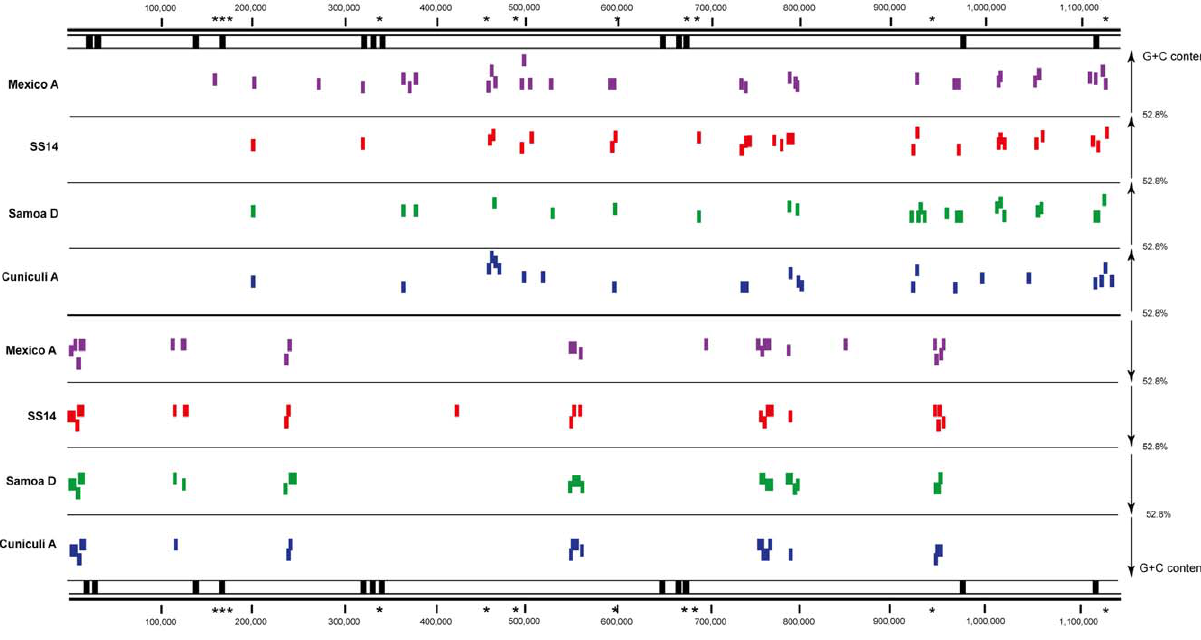
Figure 2. G + C content variation in selected Treponema strains. TPA Mexico A, TPA SS14, TPE Samoa D and Treponema paraluiscuniculi strain Cuniculi A were analyzed. Colored vertical lines represent 501 bp-long windows with G + C content above the 63% or below the 41% threshold. Black vertical lines represent genome locations of tpr genes. Stars denote 5 kb-long DNA regions with 40 or more nucleotide positions differentiating TPA and TPE strains [7]. Please note that there is no clear association of DNA regions with different G + C content and regions differentiating TPA and TPE strains [7] or locations of tpr genes.